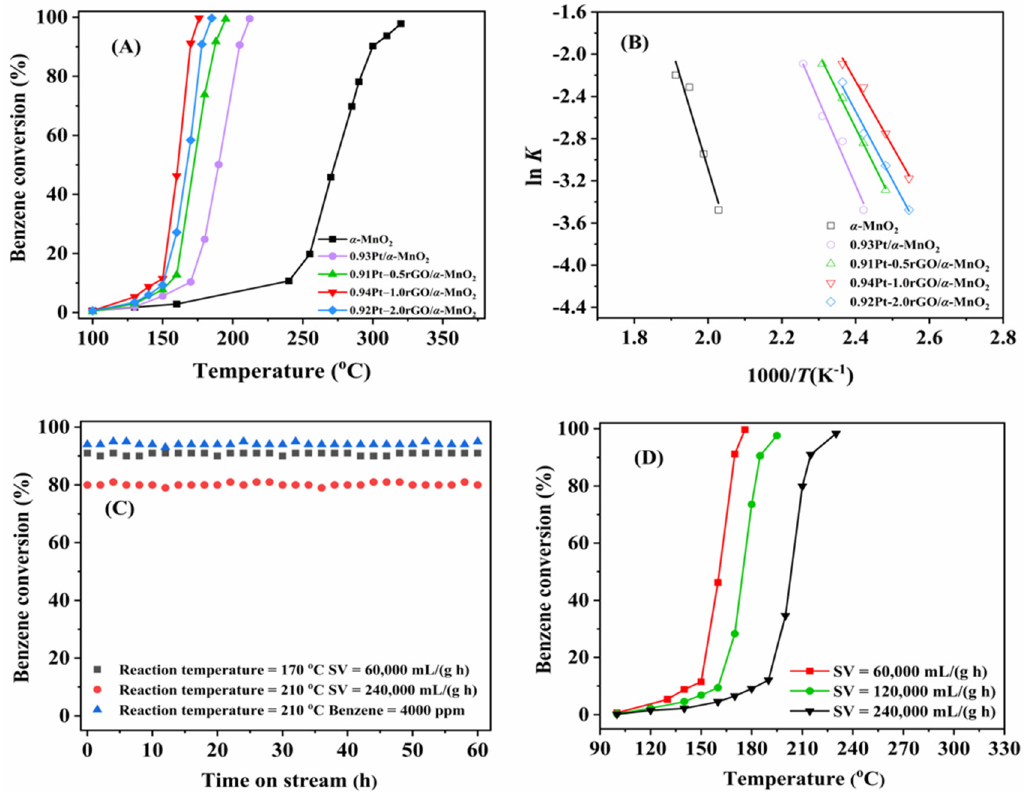
Figure 1. ( A ) Benzene conversion as a function of temperature, ( B ) Arrhenius plots for the oxidation of benzene over the α -MnO 2 and x Pt- y rGO/ α -MnO 2 samples at SV = 60,000 mL/(g h), ( C ) catalytic stability of 0.94Pt-1.0rGO/ α -MnO 2 under different conditions, and ( D ) effect of GHSV on catalytic activity of 0.94Pt-1.0rGO/ α -MnO 2 at benzene concentration = 1000 ppm. Table 1. Catalytic activities, apparent activation energies ( E a ), TOF Pt at 149 ◦ C, and specific reaction According to the activity data and the Pt loadings in the samples, their TOFs for ben- rates at 149 ◦ C ( r cat ) of the α -MnO 2 and x Pt- y rGO/ α -MnO 2 samples at GHSV = 60,000 mL/(g h). zene oxidation were calculated, as listed in Table 1. The TOFs (0.47 × 10 − 2 –1.54 × 10 − 2 s − 1 ) over x Pt- y rGO/ α -MnO 2 were significantly higher than that (0.28 × 10 − 2 s − 1 ) over rGO-free 0.93Pt/ α -MnO 2 . Among all of the samples, 0.94Pt-1.0rGO/ α -MnO 2 exhibited the highest TOF at 149 °C (5.73 × 10 − 2 s − 1 ). Furthermore, the r cat values (8.18 × 10 − 5 –3.14 × 10 − 4 mol/(g Pt s)) over x Pt- y rGO/ α -MnO 2 were higher than that (5.11 × 10 -5 mol/(g Pt s)) over 0.93Pt/ α -